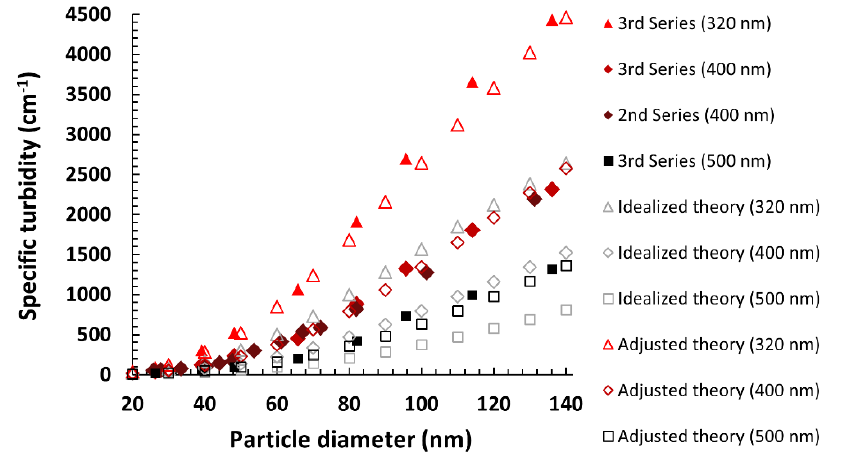
Figure 5. Superimposition of theoretical (idealized and adjusted with a multiplicative factor of 1.69) and experimental plots for τ sp = f( d ) showing good agreement and a near-linear relationship for diameters over 60 nm.